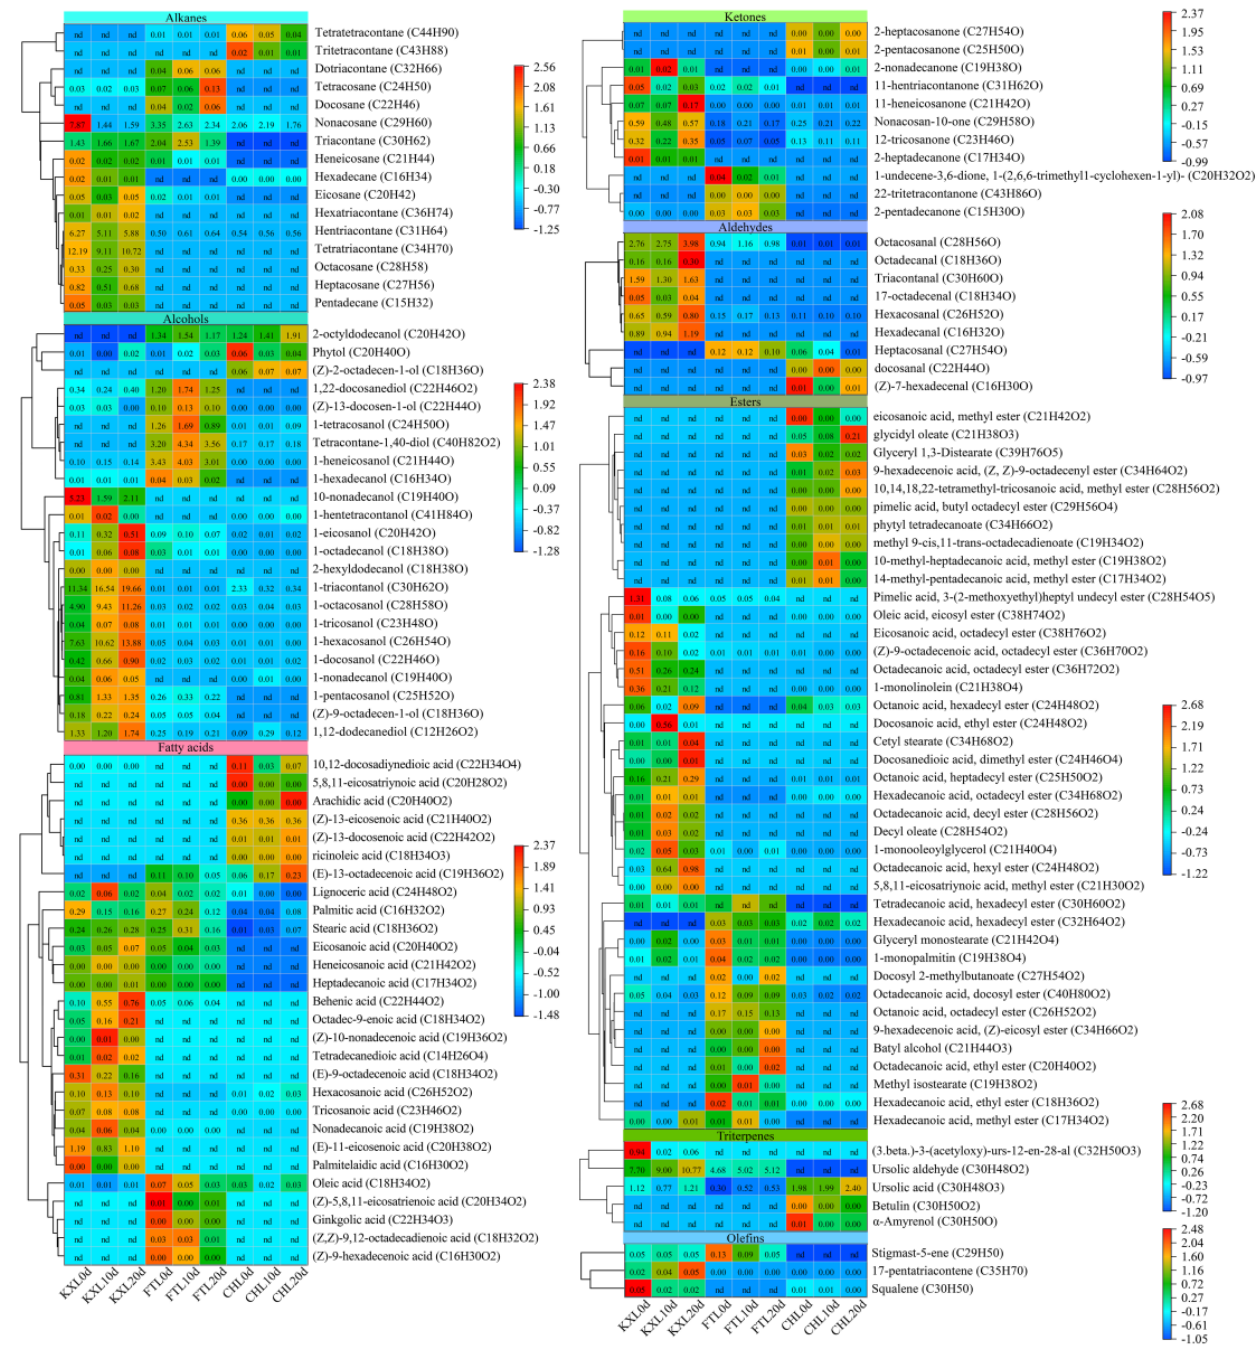
Figure 3. Change heatmaps of cuticular wax composition and concentration among three plum cultivars during storage at room temperature. Note: nd represents an undetected substance, and 0.00 means that the content of substance was lower than 0.01 μg·cm −2 . Red and blue colors indicate high and low content, respectively. Each square represents the means of three replicates ( p < 0.05).